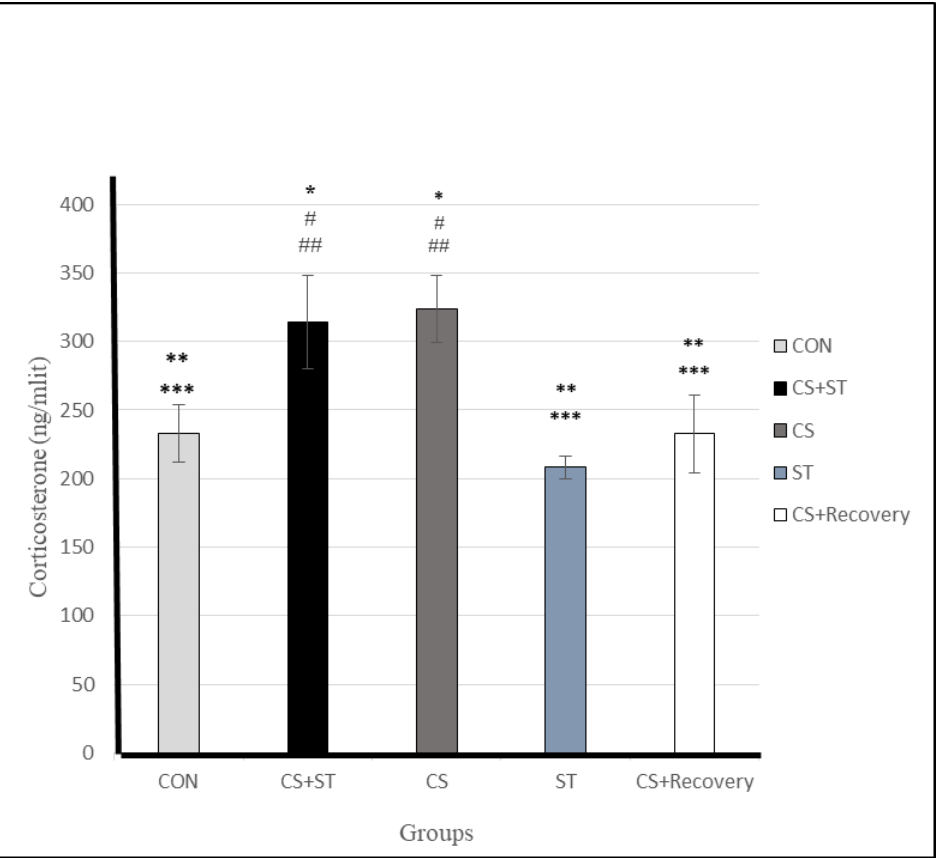
Figure 10. Total serum corticosterone (ng/mL) levels in male rats. Data are expressed as the mean ± S.E.M. * p < 0.001, significantly different from the control group. ** p < 0.001, significantly different from the CS + ST group. *** p < 0.001, significantly different from the CS group. # p < 0.001, significantly different from the ST group. ## p < 0.001, significantly different from the CS + Recovery group. CS + ST: chronic mild stress followed by swimming training, CS: chronic mild stress,